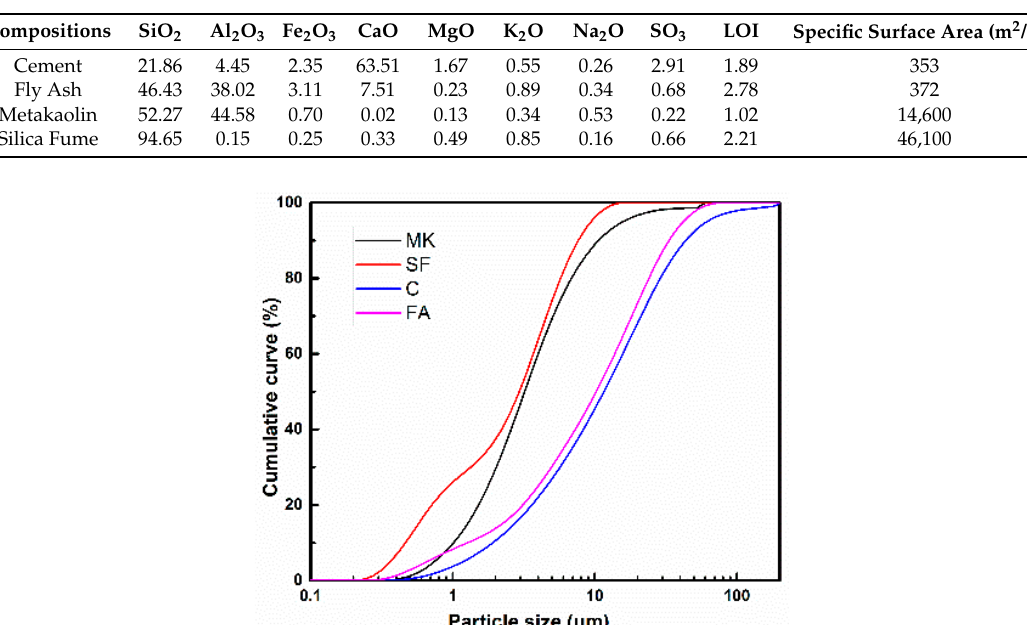
Table 1. Chemical composition of powders in this study (wt %).